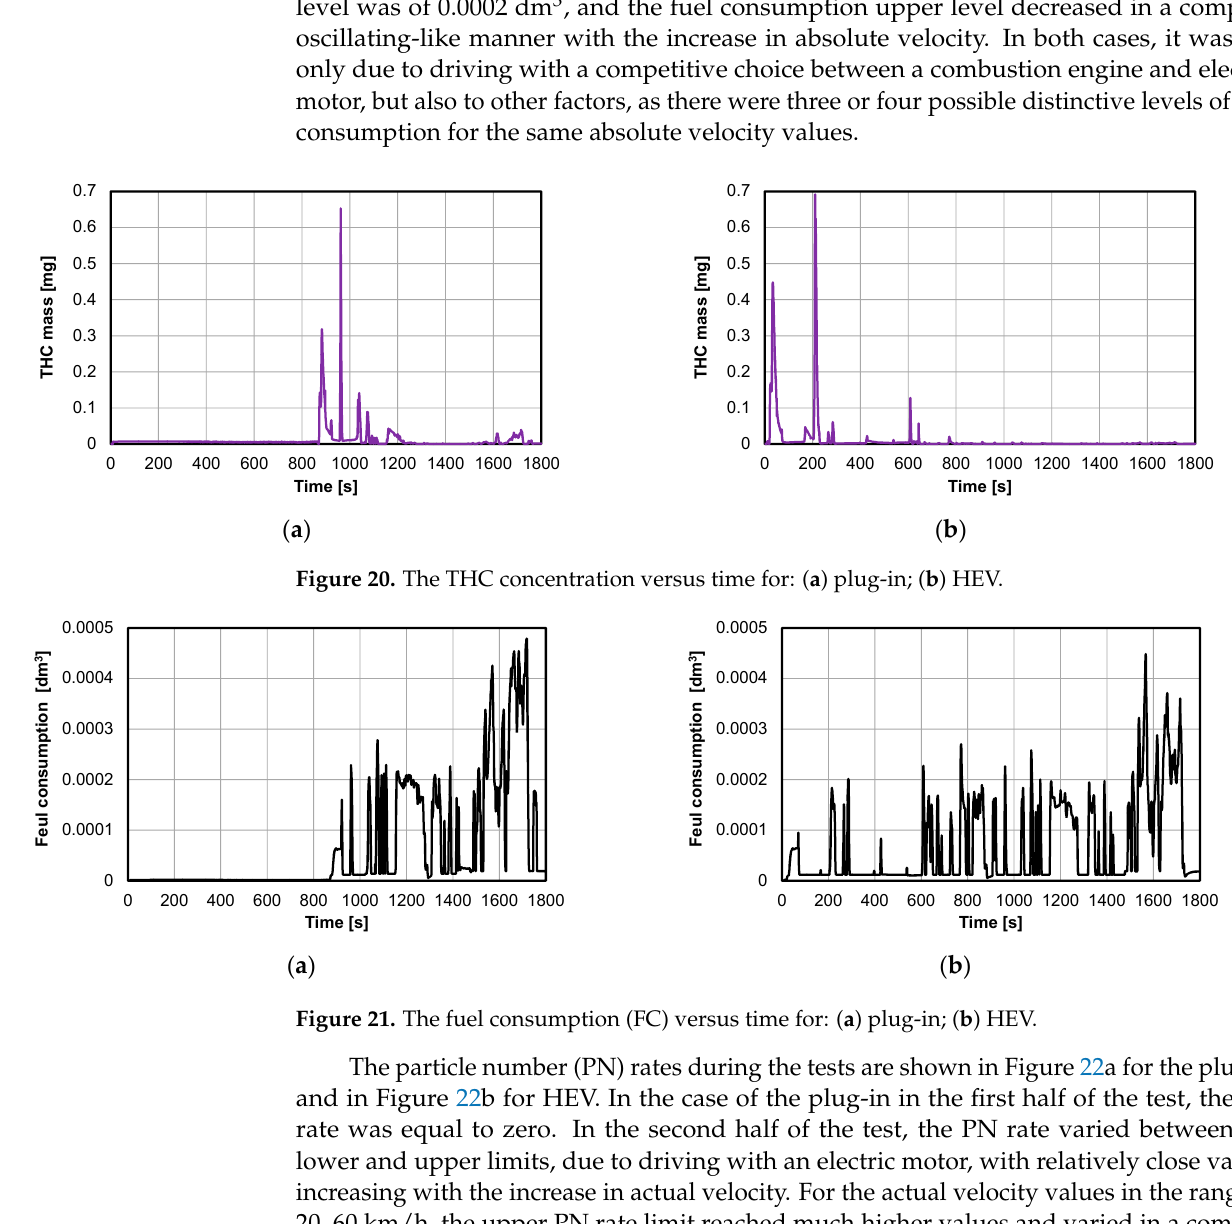
The particle number (PN) rates during the tests are shown in Figure 22a for the plug-in and in Figure 22b for HEV. In the case of the plug-in in the first half of the test, the PN rate was equal to zero. In the second half of the test, the PN rate varied between the lower and upper limits, due to driving with an electric motor, with relatively close values increasing with the increase in actual velocity. For the actual velocity values in the range of 20–60 km/h, the upper PN rate limit reached much higher values and varied in a complex manner with an increase in the actual velocity. In the case of HEV, the variations of PN rate were similar to those of the plug-in case in the second half of the test. The lower PN rate limit increased almost twice as quick with the increase in actual velocity compared to the plug-in case in the second half of the test. In both cases, the PN rate variations were due to driving with a competitive choice between a combustion engine and electric motor, but for the actual velocity values in the range of 20–60 km/h, and due to other factors, there were three or four possible distinctive levels of PN rate for the same actual velocity values. The PN variations were similar to the variations of PN rate in both cases of the plug-in and HEV. The PN in the plug-in case in the second half of the test could reach an even 20% higher peak value compared to the case of HEV. The average PN was equal to 3.79 · 10 10 for the case of the plug-in and 4.02 · 10 10 for the case of HEV.